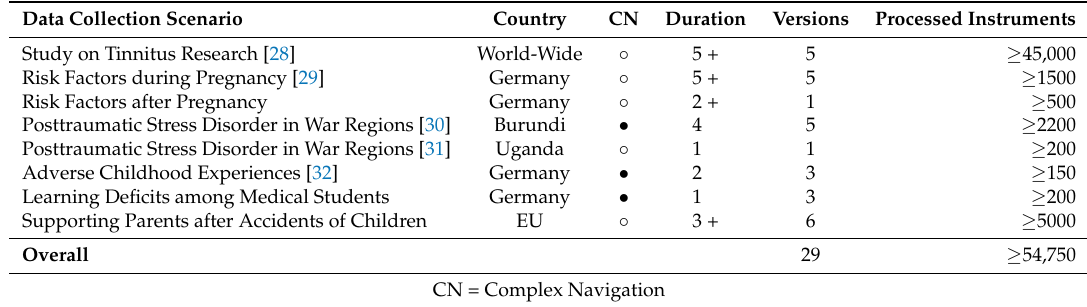
Table 1. Realized mobile data collection